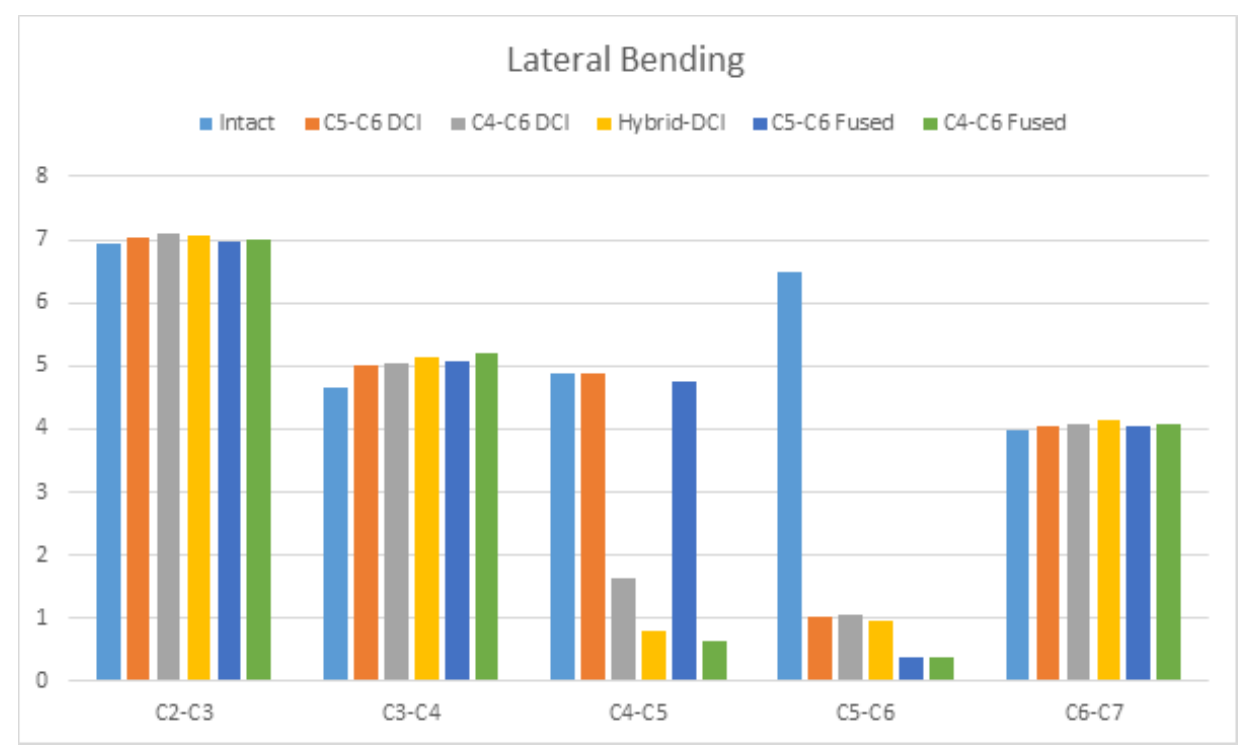
Figure 6. The comparison of ROMs during lateral bending among the C5–C6 DCI, C4–C6 DCI, hybrid DCI, C5–C6-fused, and C4–C6-fused models. The vertical axis shows ROMs in degrees.